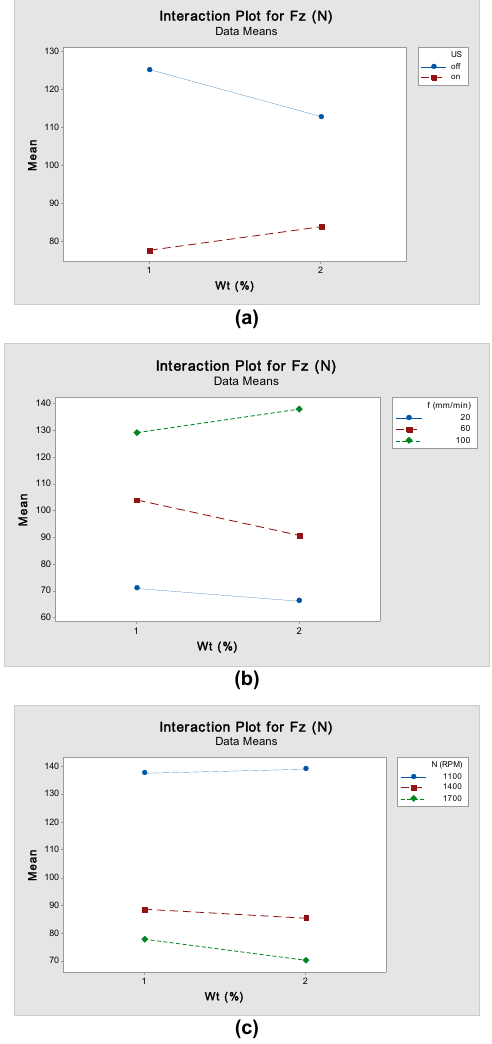
Figure 7. Interactive effect of SiC content and: (a) ultrasonic (US) vibration, (b) feed rate and (c) spindle speed; on thrust